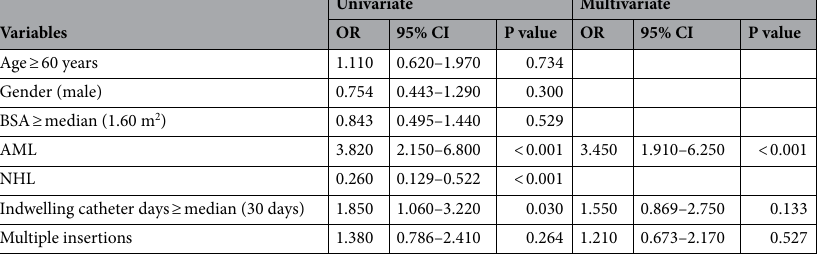
Table 4. Univariate and multivariate logistic regression analyses of risk factors for CRBSI. AML acute myeloid leukemia, BSA body surface area, CI confidence interval, CRBSI catheter-related bloodstream infection, NHL non-Hodgkin lymphoma, OR odds